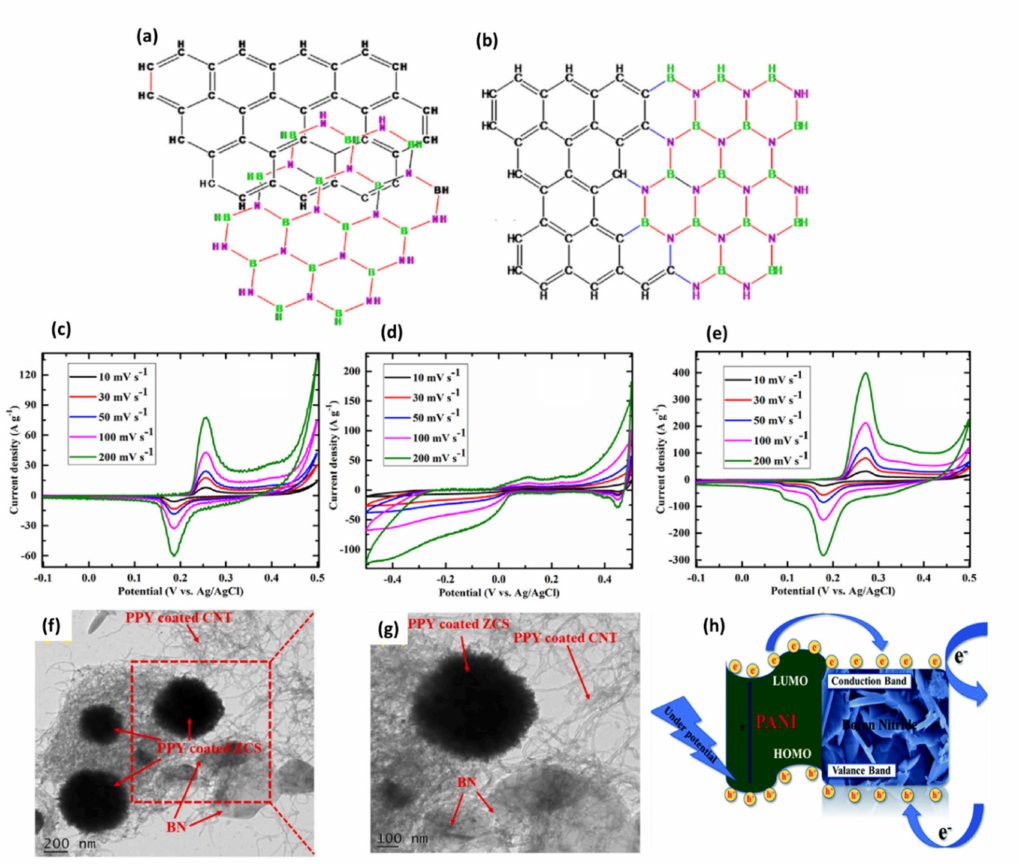
Figure 5. The atomic framework of ( a ) h-BNG2 and ( b ) h-BNG3. CV of ( c ) hB-NG1 ( d ) h-BNG2, and ( e ) h-BNG3 at different scan rates [104] (Reprinted with permission from Elsevier B. V, Copyright © 2017). TEM images of ZCS/BN/CNT/PPY at ( f ) lower and ( g ) higher magnification [103] (Reprinted with permission from Elsevier B. V, Copyright © 2020). ( h ) Schematic of the probable electron transfer mechanism within PANI and BN under an applied potential [107] (Reprinted with permission from Royal Society of Chemistry, Copyright ©